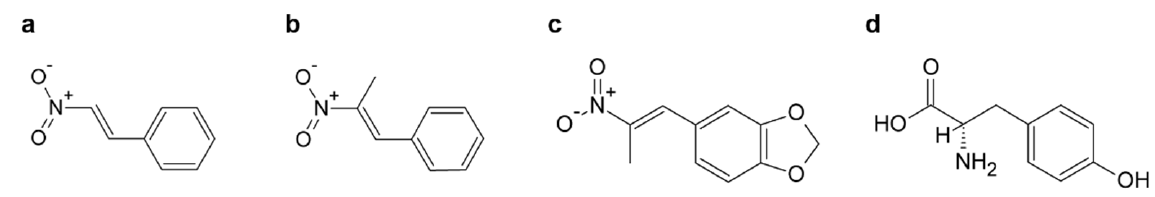
Figure 1. Structures of the active pharmacophores of the nitroalkenyl benzenes: ( a ) NEB ([(E)-2-nitroethenyl]benzene) and ( b ) NPB ((2-nitroprop-1-enylbenzene) and ( c ) NPBD ((5-[(E)-2-nitroprop-1-enyl]-1,3-benzodioxole) an active antimicrobial mimetic of ( d ) tyrosine (2-amino-3-(4-hydroxyphenyl)propanoic acid).